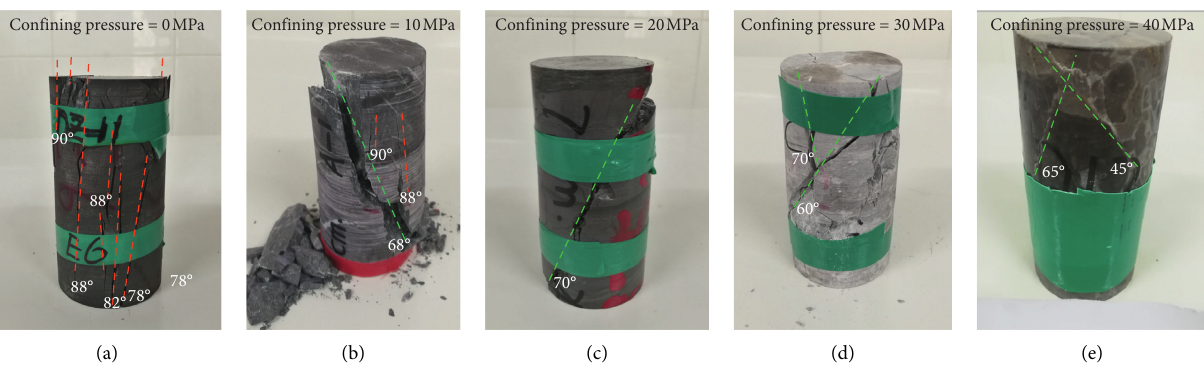
Figure 10: Failure modes of Yunnan limestone under different confining pressures. (a) Splitting failure. (b) Tension-shear mixed failure. (c) Single inclined surface shear failure. (d) Y-shaped shear failure. (e) X-shaped shear failure. The dashed line in red represents the tensile crack. The dashed line in green represents the shear